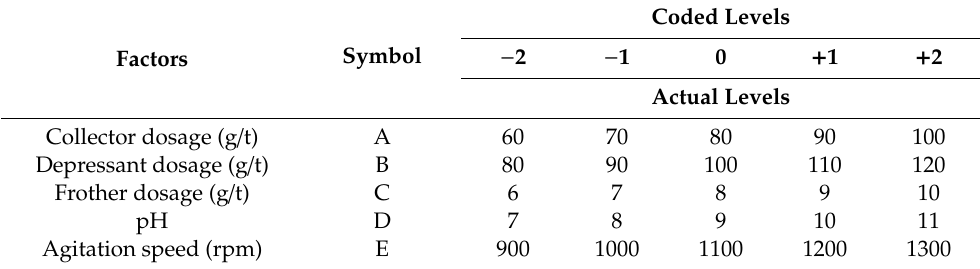
Table 4. The main factors influencing the copper flotation process and their levels.